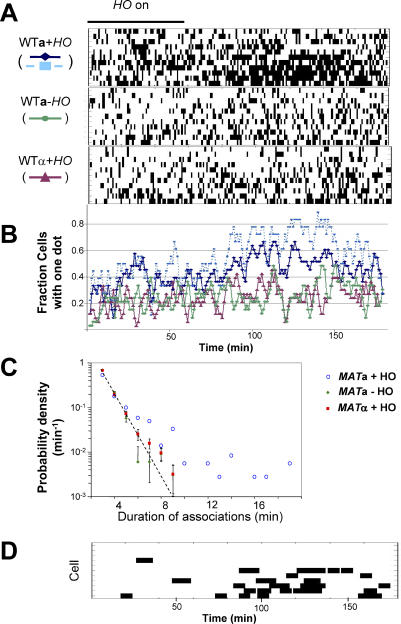
Pairing In Vivo between MAT and HML Increases following Introduction of a DSB at MAT
(A) Shown are cell histories for 11 cells each from three strains, configured as diagrammed in Figure 1, indicating along the horizontal time line for each cell whether at each time point the cell presented a single dot (black bar) or two dots (white bar). Cells were interrogated at 1-min intervals for 3 h with galactose present (HO induced) for the first hour. Upper group: Y3343 (MAT
a) transformed with B2609; middle group: Y3343 (MAT
a) transformed with pRS415 [46]; and lower group: Y3342 (MATα) transformed with B2608.(B) At each time point, the fraction of cells exhibiting a single dot was determined from the data underlying Figure 2A and plotted as a three-point running average versus time following addition of galactose. Legends are indicated to the left of the cell histories in (A). Data were calculated either including all 11 Y3343 (MAT
a) cells transformed with B2609 (dark blue diamonds) or for only those six cells presumed to have sustained a DSB at MAT (light blue rectangles). The horizontal axis is aligned with the cell histories in (A).(C) The duration of periods of apparent continuous association between MAT and HML. The number of continuous, uninterrupted time points in which a cell shows only a single dot, were determined from the cell histories in Figure 2A. The number of periods of a given duration divided by the total number of periods (probability density) is plotted versus the duration of apparent association for each strain shown in 2A. MAT
a + HO (light blue circles); MAT
a − HO (green diamonds); and MATα + HO (red squares). Error bars are estimated by dividing the data successively into random halves and computing the standard deviation among 20 random halves. The dashed line shows a fit of the combined values for MAT
a − HO and MATα + HO cells to a normalized, exponential distribution. Under this assumption, the p-value for the likelihood that the data for MAT
a + HO would arise by chance is less than 10−5.(D) Data from Figure 2A for MAT
a + HO cells is replotted to show only those pairing events of duration longer than 6 min.